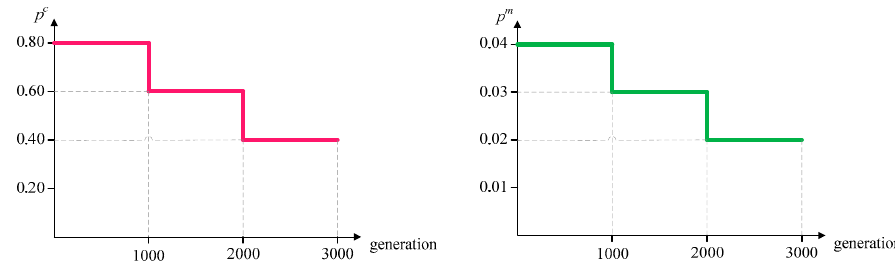
Figure 8. Examples of piecewise functions for the crossover and mutation probabilities within DPCEA. Table 3. The parameter tuning analysis results for the developed solution